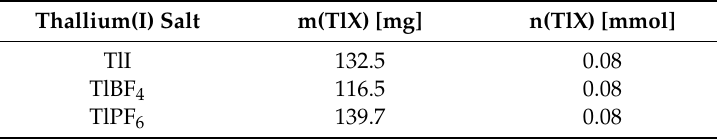
Table 1. Amounts of the used thallium(I) salts.